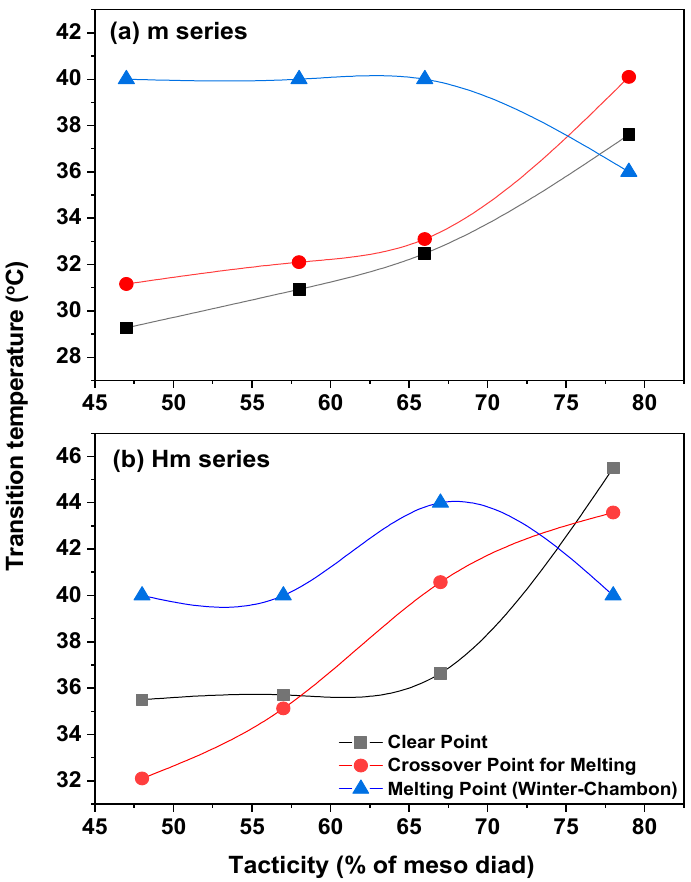
Figure 5. The G’-G” crossover point for melting procedure ( ● ), the melting point determined by Winter-Chambon criterion ( ▲ ), and the clear point determined by transmittance measurement ( ■ ), as a function of the tacticity for ( a ) m and ( b ) Hm series with concentration of 5%.